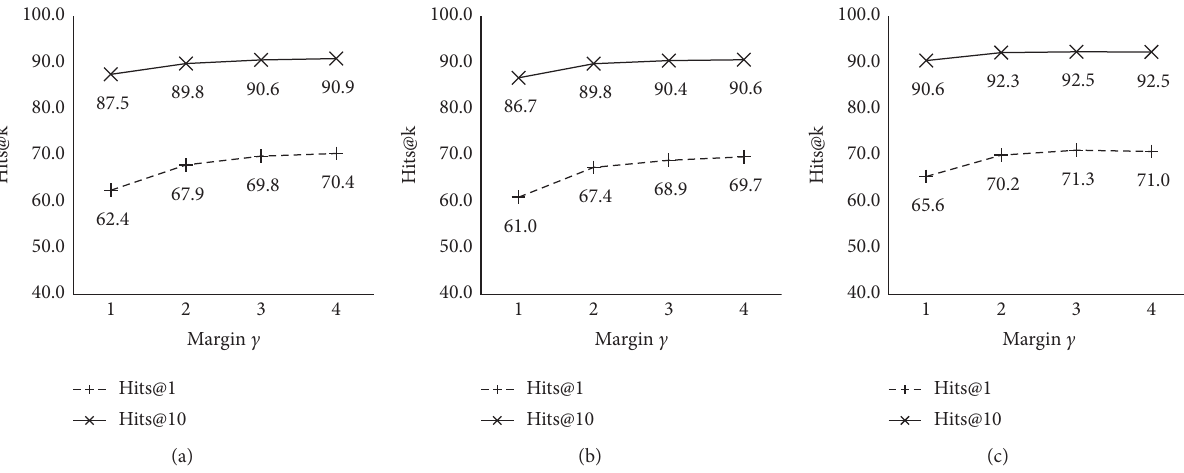
Figure 6: CAREA performance with respect to the margin parameter c . (a) DBP